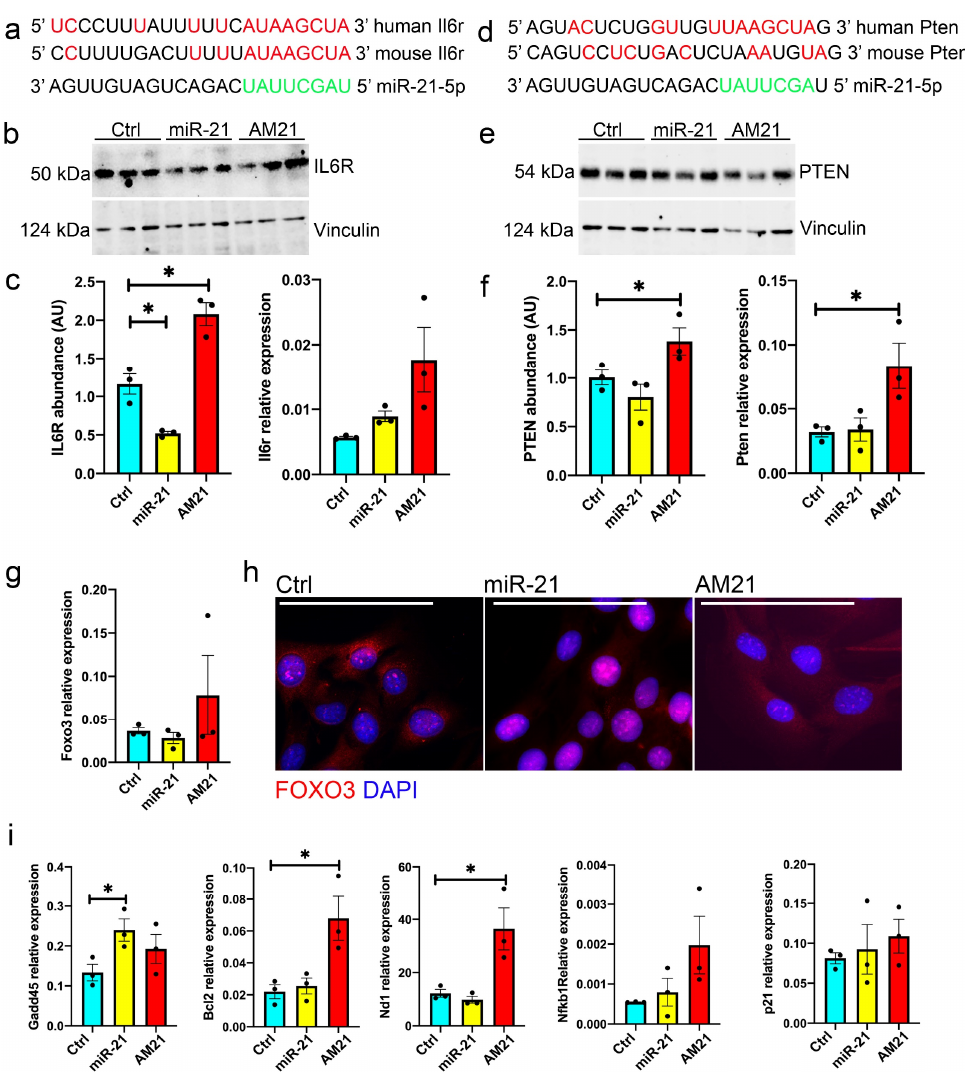
Figure 5. miR-21 regulates the expression of Il6r in mouse primary myoblasts. ( a , d ) Alignment of putative miR-21 target site in the 3 (cid:48) UTR of Il6r and Pten genes, respectively; human and mouse sequences are indicated; conserved miR-21 putative target site is indicated in green; complementary nucleotides are shown in red. ( b , c ) Primary mouse myoblasts were transfected with miR-21 mimic or antimiR (AM21). Endogenous IL6R protein but not mRNA expression is regulated by miR-21 in the mouse myoblasts, as shown by Western blot and qPCR, respectively. ( e , f ) Inhibition of miR-21 leads to upregulation of Pten mRNA and protein levels as demonstrated by Western blot and qPCR, respectively. ( g – i ) miR-21 does not significantly a ff ect Foxo3 mRNA levels ( g ), however miR-21 upregulation results in translocation of FOXO3 into the nucleus ( h ) and upregulation of stress response gene: Gadd45 ( i ), whereas miR-21 inhibition (AM21) results in upregulation of antiapoptotic gene Bcl-2 and increase in mitochondrial marker Nd-1 as compared to mock-treated cells and miR-21 does not a ff ect cell cycle regulator: p21 ( i ). Myoblasts treated with miR-21 or AM21 were stained for FOXO3 and DAPI; representative images shown; Expression relative to β -2 microglobulin, S18 and S29 shown. qPCR data show SEM; • indicates individual replicates, * p < 0.05 (compared to control—mock transfected cells); n = 3. Scale bar = 50 µ